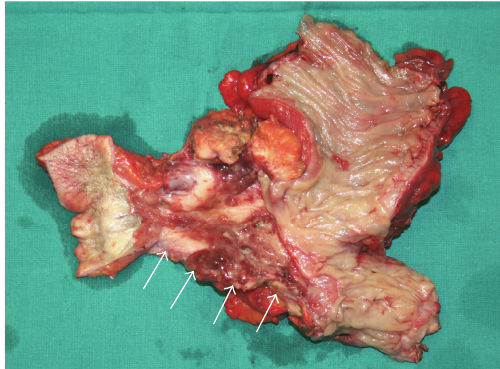
Figure 3: The resected specimen demonstrating the fibrotic fistu- lous tract (arrows) between the umbilicus and the sigmoid colon lined with granulation